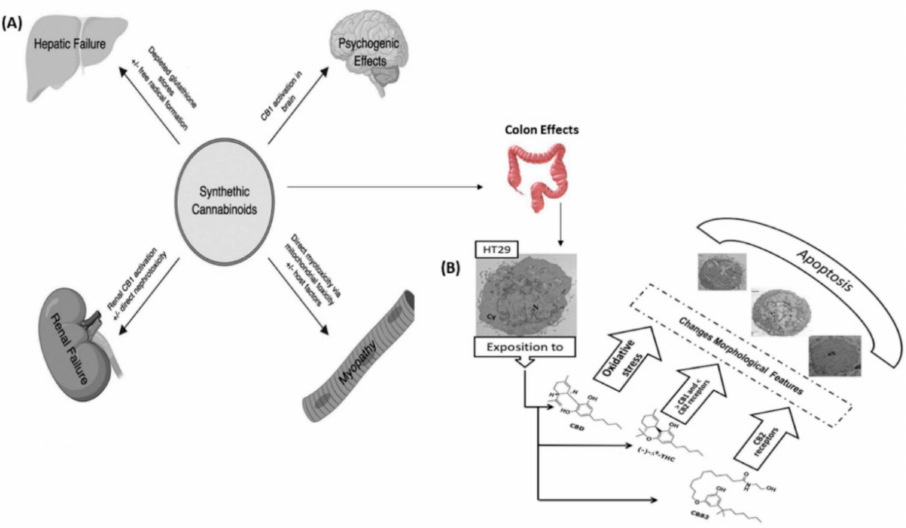
Figure 4. Schematic illustration of ( A ) proposed mechanisms of synthetic cannabinoids end-organs effects, and ( B ) their cytotoxic effects on human HT-29 colorectal adenocarcinoma cells (reprinted with permission from [120,121]; copyright (2019) (2020) ACCP; MDPI; the articles were printed under a CC-BY